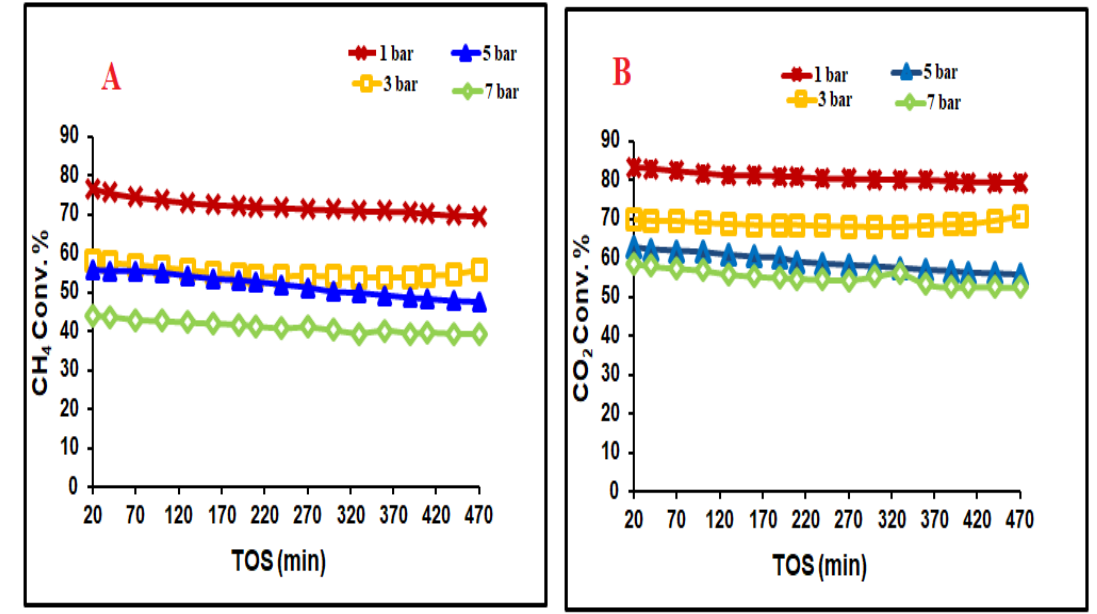
Figure 3. TOS against ( A ) methane and ( B ) carbon dioxide conversions, for catalyst at 725 ° C, 700 ° C calcination and reaction respectively, 0.05g catalyst, CH 4 = 30 mL/min, CO 2 = 30 mL/min, N 2 = 10 mL/min, GHSV = 84000 (mL/g/h).